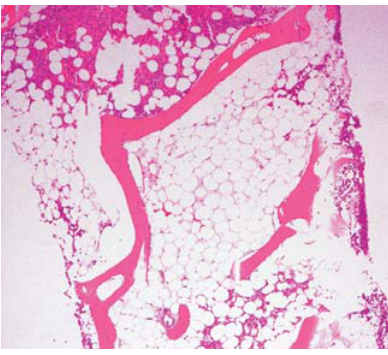
Figure 2. Bone Marrow Biopsy on Admission, Showing Predominantly Hypocellular Bone Marrow DOI: